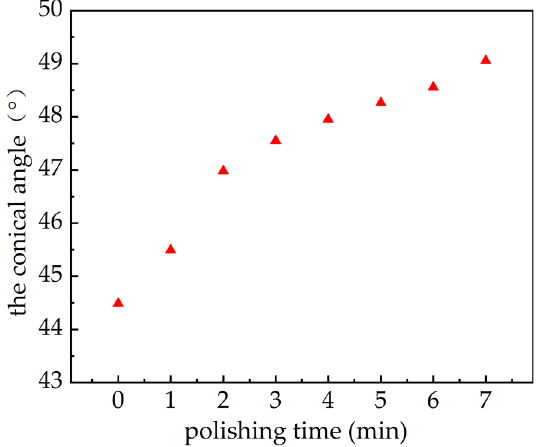
Figure 6. The relationship between the conical angle and electrolytic polishing time.